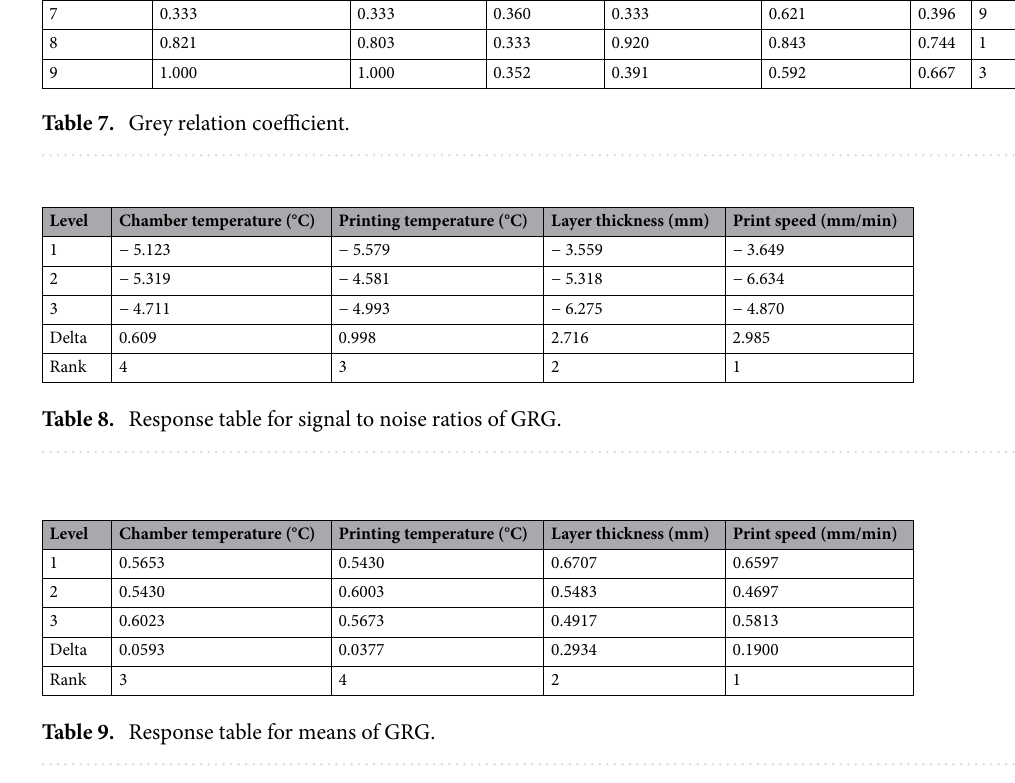
Table 9. Response table for means of